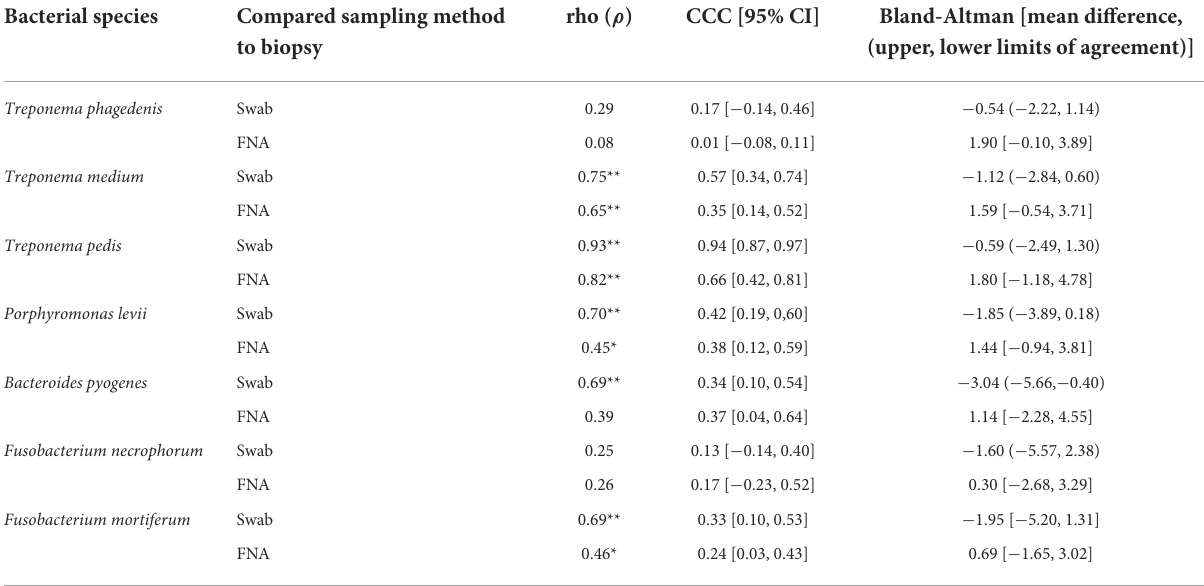
TABLE 2 Spearman’s correlation coefficient, Lin’s Concordance Correlation Coefficient, and Bland-Altman results of bacterial quantification of each species in DD M2 lesions ( n = 22) among the sampling methods. Bacterial species Compared sampling method rho ( ρ ) CCC [95% CI] Bland-Altman [mean difference, to biopsy (upper, lower limits of agreement)]